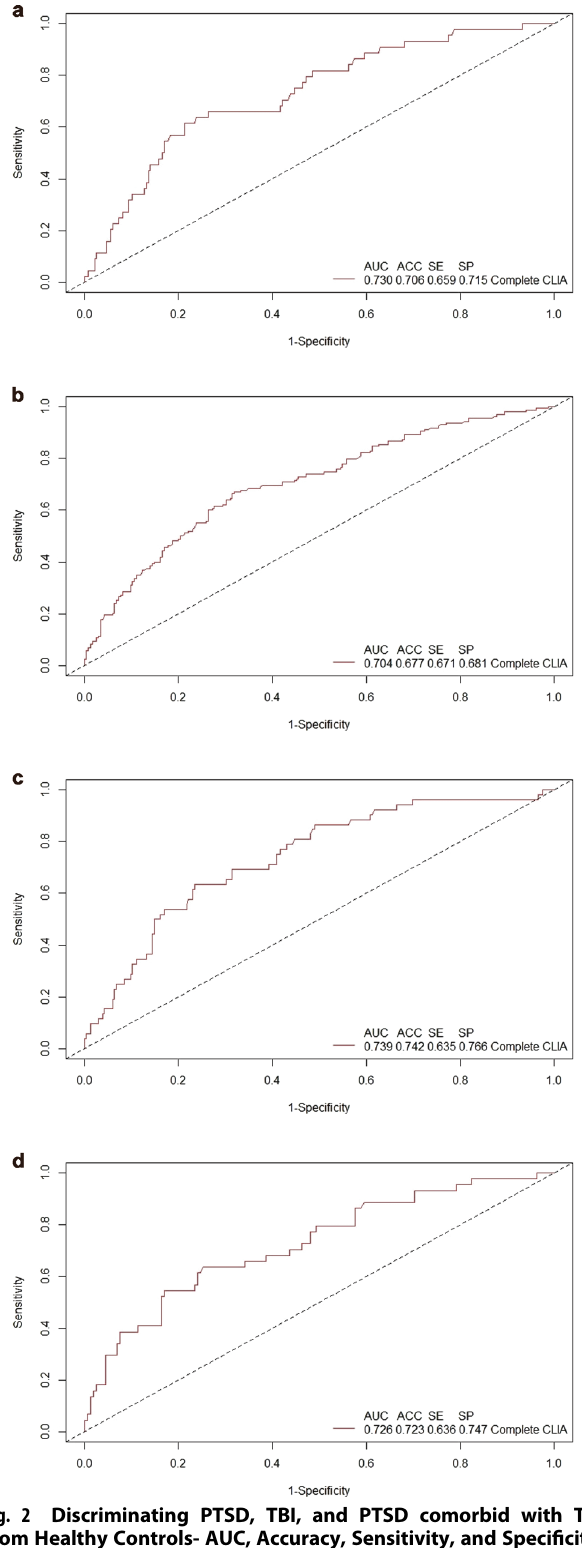
Fig. 2 Discriminating PTSD, TBI, and PTSD comorbid with TBI from Healthy Controls- AUC, Accuracy, Sensitivity, and Speci fi city. a Discriminating PTSD from Healthy Controls - AUC, Accuracy, Sensitivity, and Speci fi city b Discriminating TBI from Healthy Controls -AUC, Accuracy, Sensitivity, and Speci fi city c Discriminating PTSD comorbid with TBI from Healthy Controls- AUC, Accuracy, Sensitivity, and Speci fi city d Discriminating PTSD from TBI- AUC, Accuracy, Sensitivity, and Speci fi